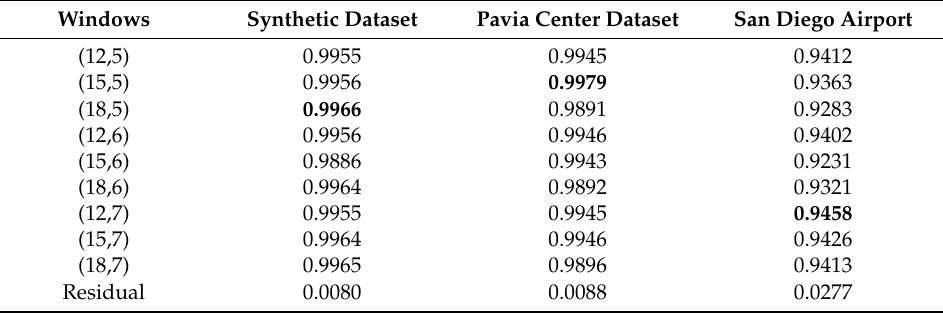
Table 1. AUC performance of the PLP-KRXD with a changing window size for the three hyperspectral imagery (HSI) datasets: Synthetic dataset, Pavia Center dataset, and San Diego Airport dataset.